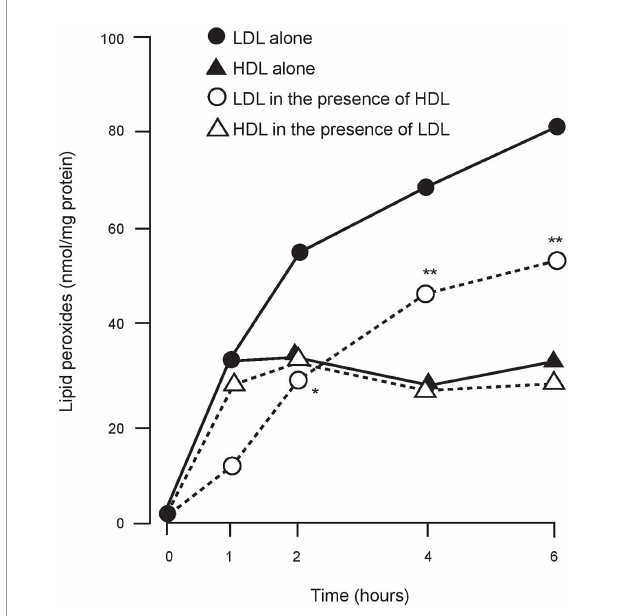
FIGURE1 The accumulation of lipid peroxides on LDL and HDL when incubated alone and together in the presence of Cu 2 + . LDL + HDL significantly different from LDL alone. ∗ P < 0.05; ∗∗ P <